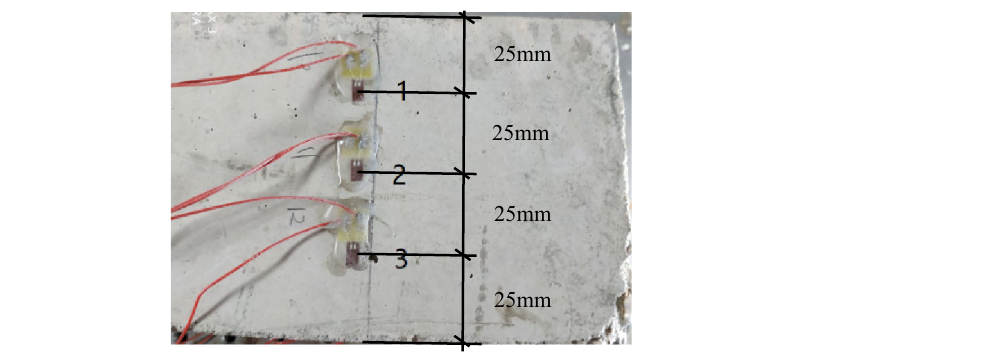
Figure 6. Positions, layouts and sequences of strain